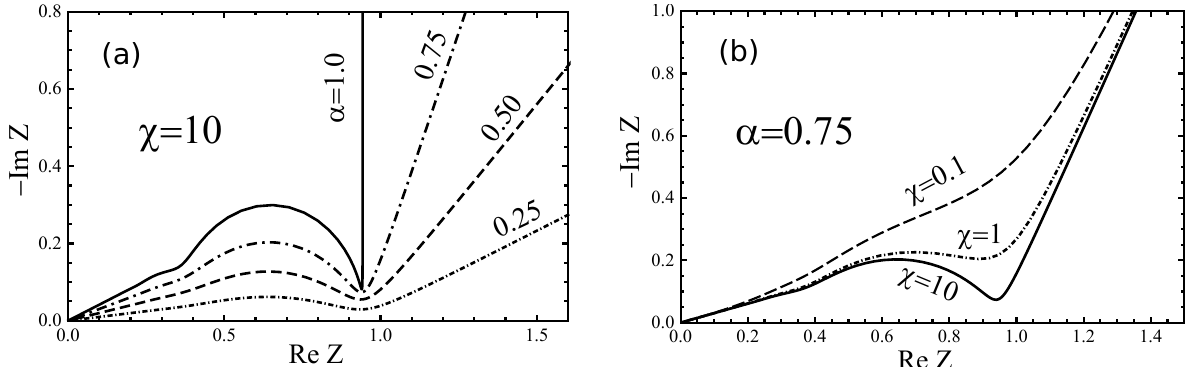
Figure 4. Nyquist plots corresponding to the RL-CH model for different values of α ( a ) and χ ( b ) with reflecting boundary condition ( l =